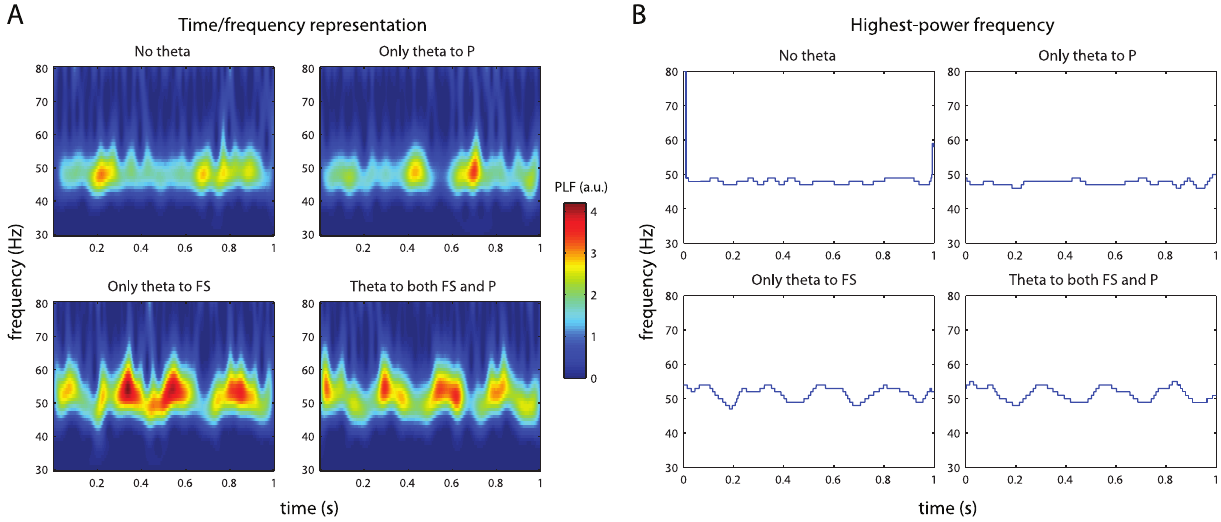
Figure 6. Effect of theta-modulated input on LFP gamma frequency. (A) Time-frequency representations of one second of simulated LFP activity. The four panels correspond to theta-modulated input fibres projecting to different parts of the model network. (B) The frequency within the gamma band with the highest power, for the same data segments shown in A. Theta phase/gamma frequency coupling is observed if and only if the FS cells receive theta-modulated input.